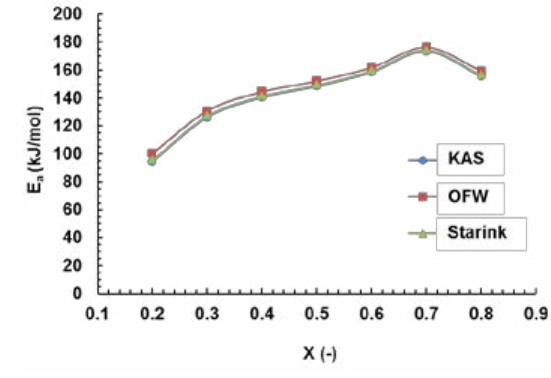
Fig. 6: E a vs X for the KAS, OFW, and Starink Fig. 6: E vs X for the KAS, OFW, and a